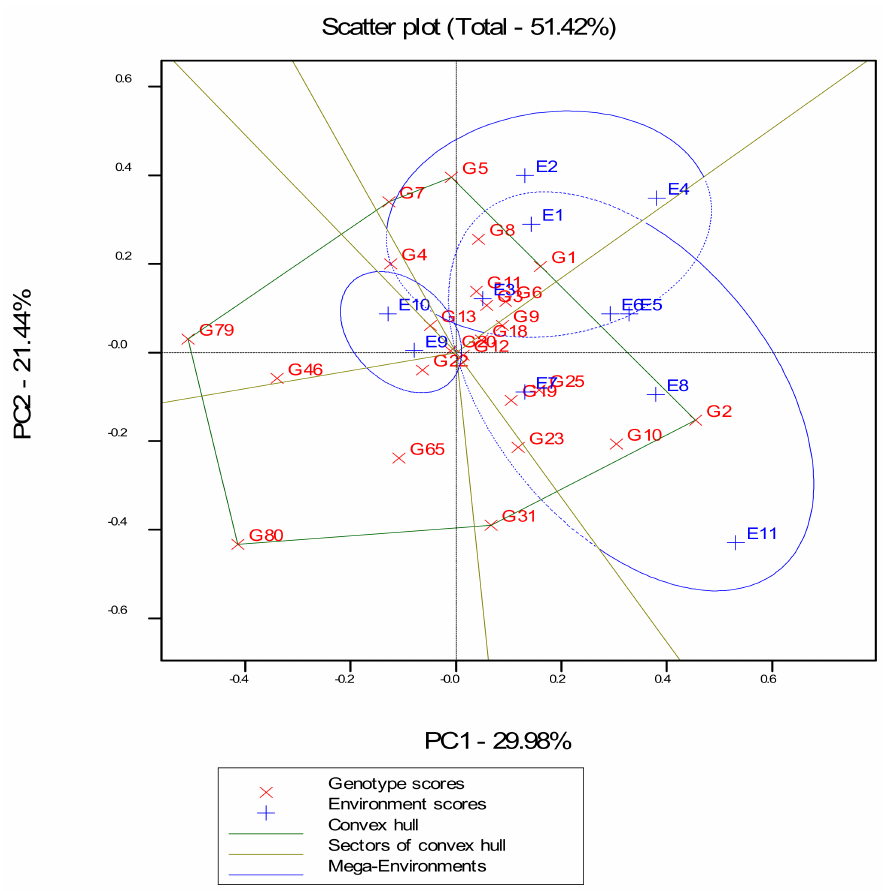
Figure 3. A “which won where” biplot based on grain yield of 24 single hybrids evaluated in 11